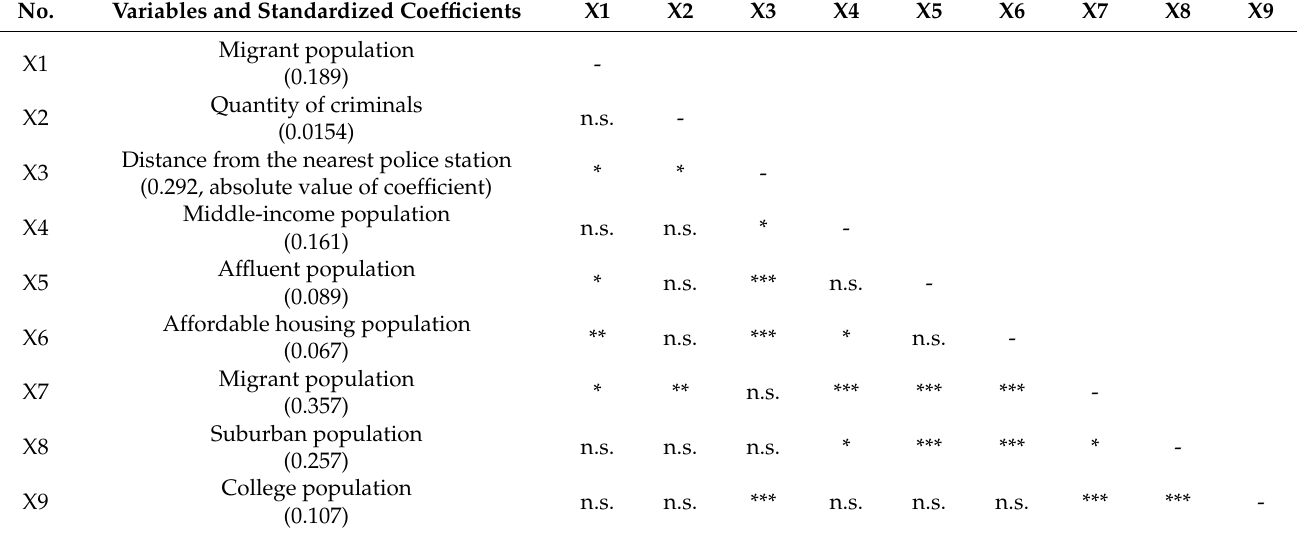
Table 5. Wald test of standardized coefficients for each pair of key